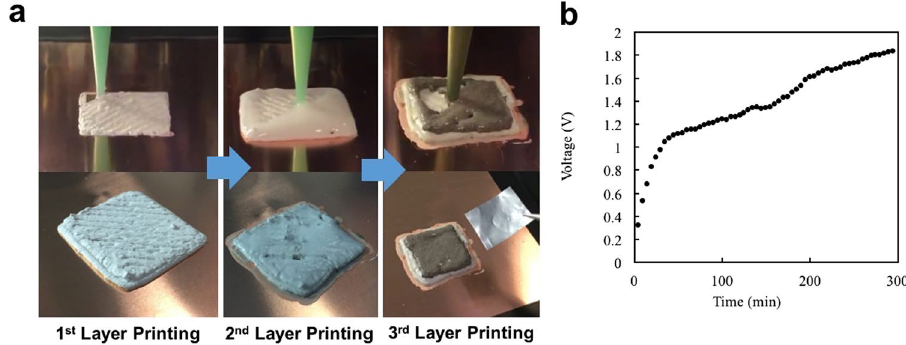
Figure 4. ( a ) Images of 3D printing process of the 3D printed battery. Anode, electrolyte and cathode are sequentially printed to form a three-layered battery structure and Performance of 3D Printed Battery ( b ) Plot of battery’s charging profile. Voltage measurement of the